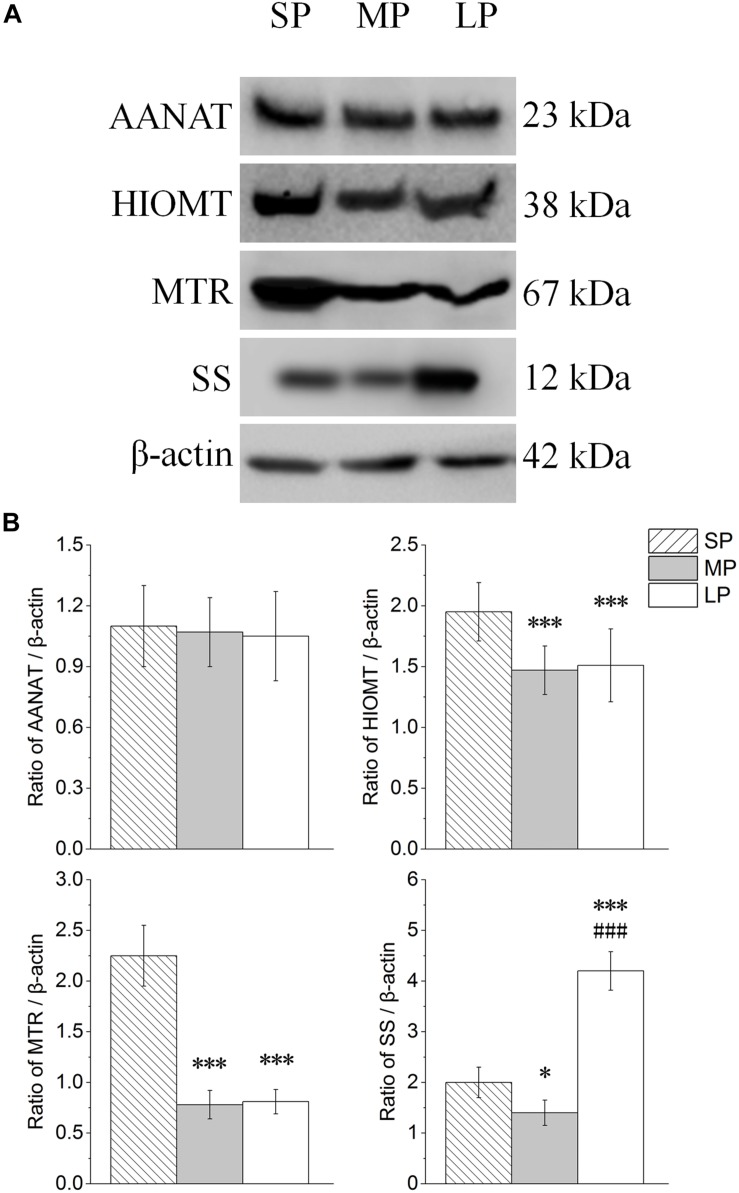
Changes in protein levels of AANAT, HIOMT, MTR, and SS in HG of hamsters in three different photoperiodic groups. (A) Representative immunoblots of AANAT, HIOMT, MTR, SS, and β-actin in three different photoperiodic groups. (B) Ratio of AANAT, HIOMT, MTR, SS to β-actin in HG of hamsters in three different photoperiodic groups. Values are means ± SD. n = 10. SP, short photoperiod; MP, moderate photoperiod; LP, long photoperiod. ∗P < 0.05, ∗∗∗P < 0.001 compared with SP; ###P < 0.001 compared with MP.